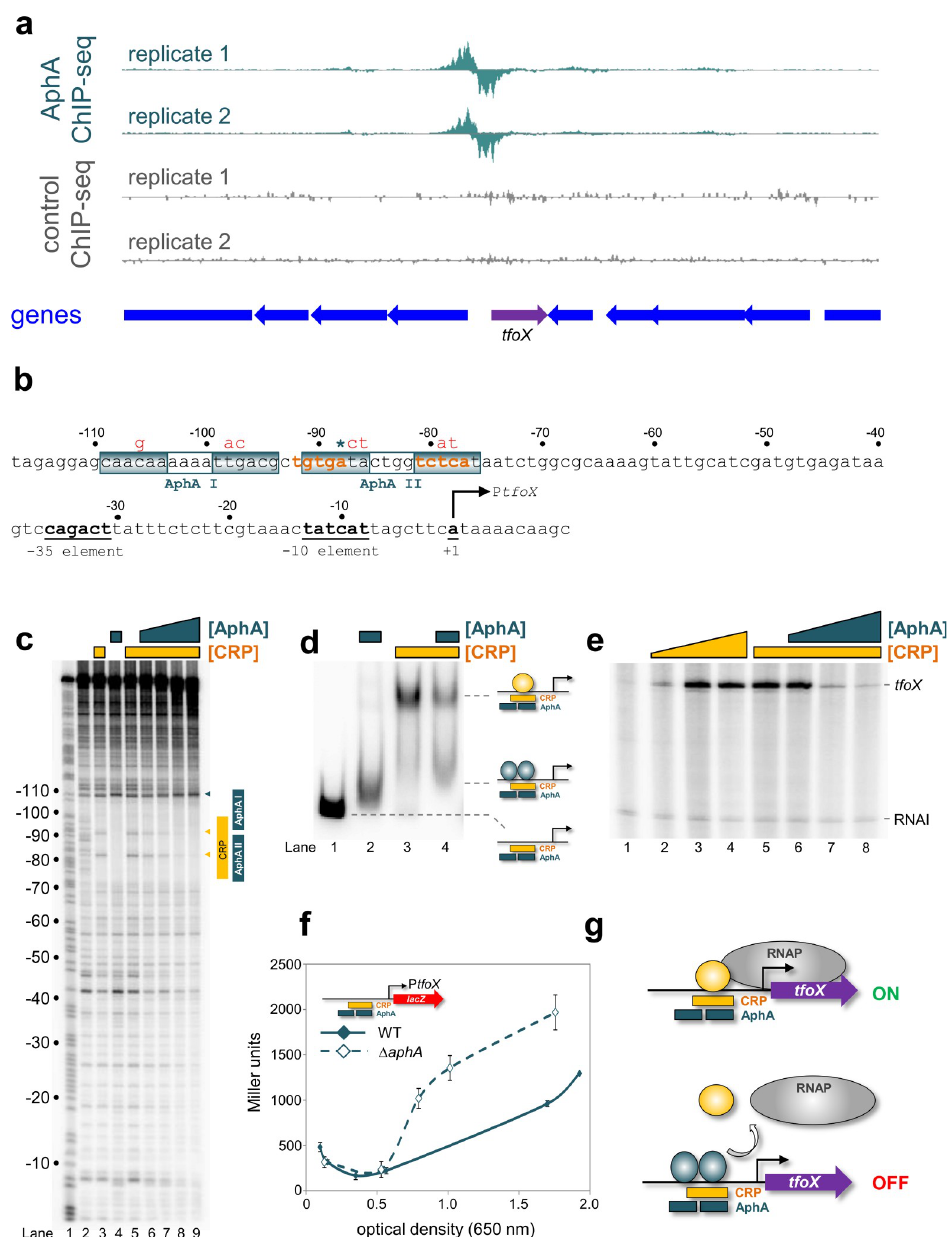
Fig 3. Repression of tfoX expression by AphA. (a) AphA binds at the tfoX locus in vivo . Genes are shown as block arrows. ChIP-seq coverage plots are shown for individual experimental replicates. Data for AphA are in teal and control profiles are grey. Signals above or below the horizontal line correspond to reads mapping to the top or bottom strand respectively. (b) DNA sequence of the tfoX regulatory region. The -35 and -10 elements are underlined and labelled, and the transcription start site is shown as a bent arrow. Distances are with respect to the tfoX transcription start site. The CRP binding site is orange and AphA sites are boxed. The ChIP-seq peak centre is denoted by an asterisk. Red bases above the sequence indicate mutations made to each AphA site. (c) Binding of AphA and CRP to overlapping sites at the tfoX promoter. The gel shows the result of DNase I footprinting experiment. The gel is calibrated with a Maxim/Gilbert ‘G+A’ ladder in lane 1. Protection of DNA from DNase I cleavage in the presence of 0.5 μ M CRP is shown in lane 3 and highlighted by the vertical yellow bar. Sites of DNAse I hypersensitivity due to CRP binding are indicated by yellow triangles. Protection from DNase I cleavage in the presence of 1.0 μ M AphA is shown in lane 4 and is highlighted by vertical teal bars. Increased DNase I cleavage induced by AphA is indicated by a teal triangle. In the presence of 0.5 μ M CRP, increasing concentrations of AphA result in the replacement of the CRP footprint with an AphA footprint (lanes 5–9, AphA concentrations: 0, 0.5 μ M, 1.0 μ M, 2.0 μ M, 3.0 μ M). (d)